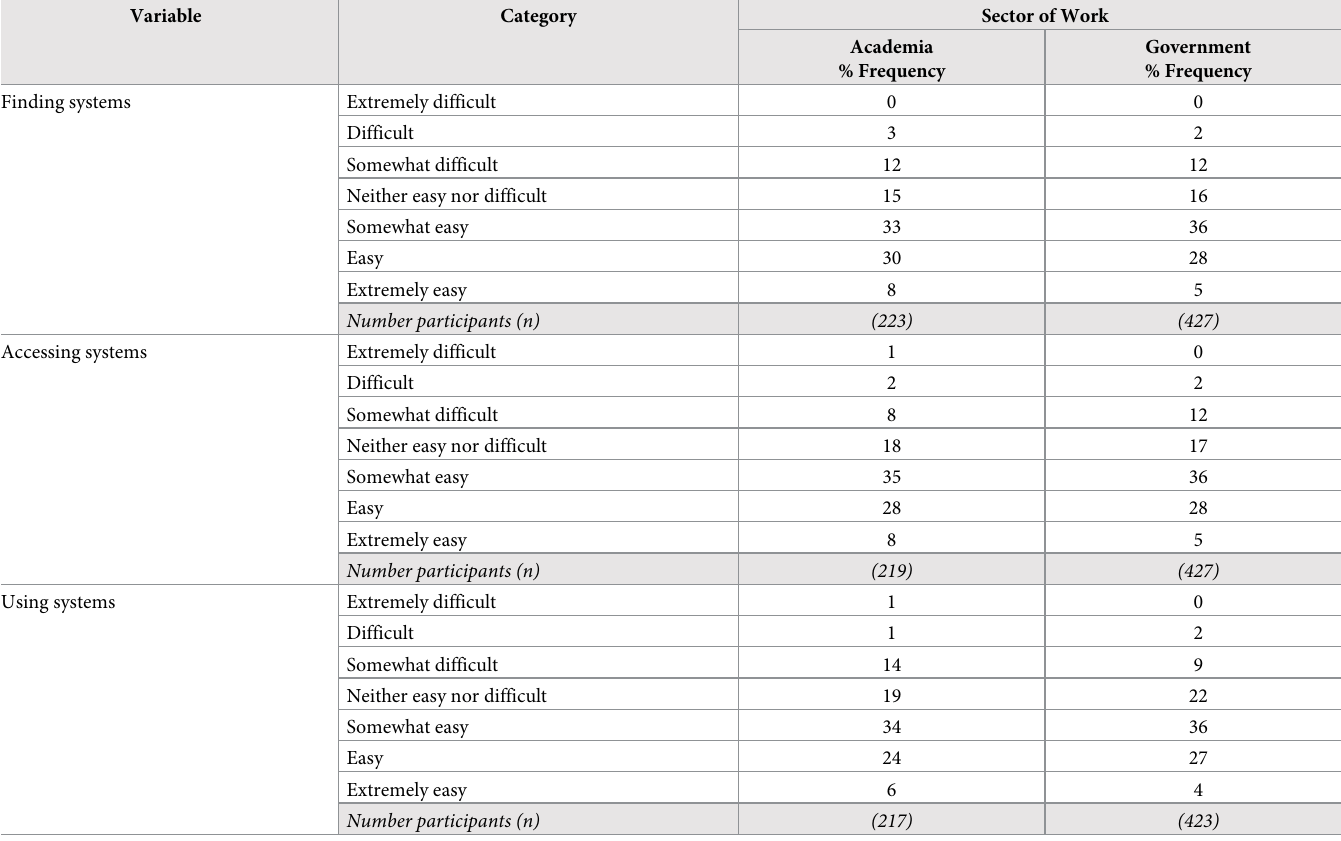
Table 12. Level of ease / difficulty of aspects related to using web-based species occurrence information systems.